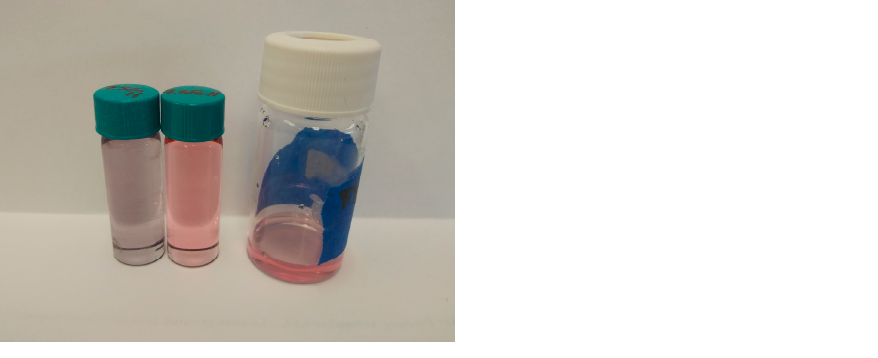
Figure A4. Photograph of samples with 7.5 mole ratio of Bipy:Cu and Bipy:Fe compared with 1% Bipy all in 90% HAN solution.